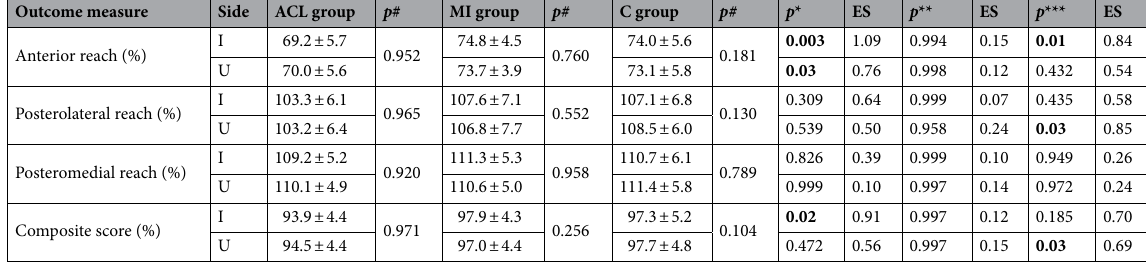
Table 3. Comparison of Y-balance variables between study groups. p < 0.05 values are indicated in bold. Values are expressed as Mean ± SD. H, Kruskal–Wallis test value between study groups. ES, effect size (Cohen d) between study groups. p * p value between ACL group and MI group (the p value there is the post-hoc of study groups main effect). p ** p value between MI group and C group (the p value there is the post-hoc of study groups main effect). p *** p value between ACL group and C group (the p value there is the post-hoc of study groups main effect). p # p value between involved (I) and uninvolved (U) side within each group.